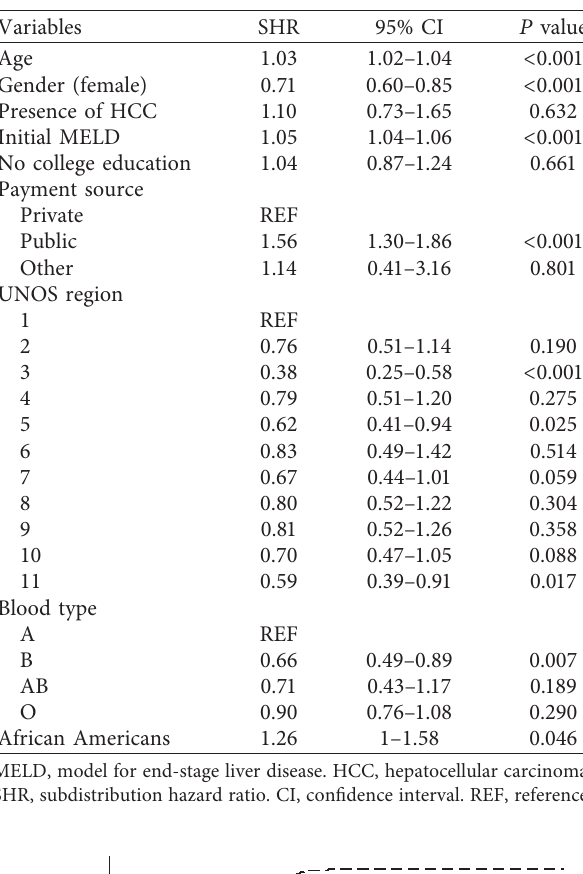
Table 3: Multivariate competing risk regression analysis for death or waitlist removal for clinical deterioration with transplant as a competing risk.